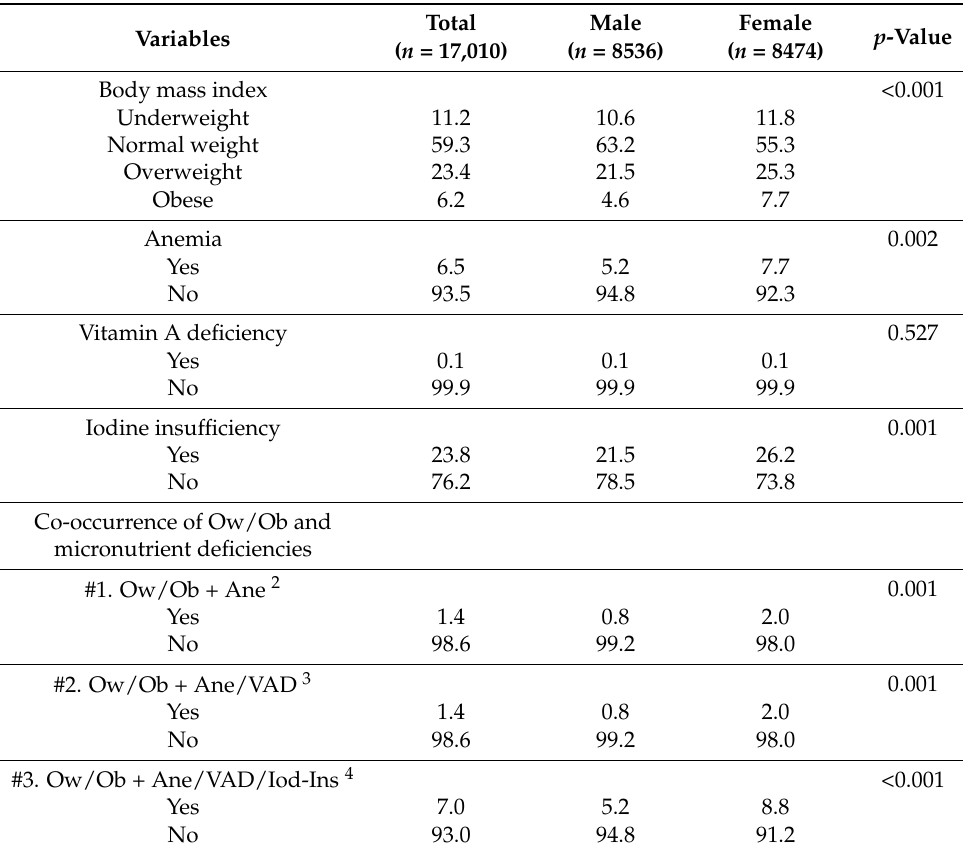
Table 2. Nutritional status of adults in the Philippines 1